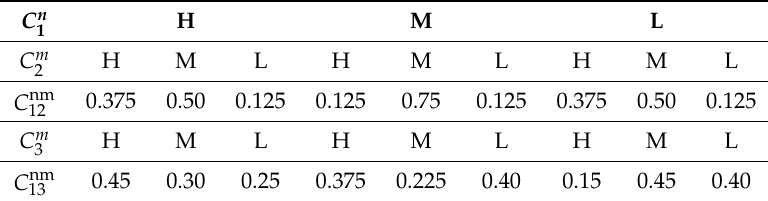
Table 6. Posteriori Probability Obtained by Microgrid 1.